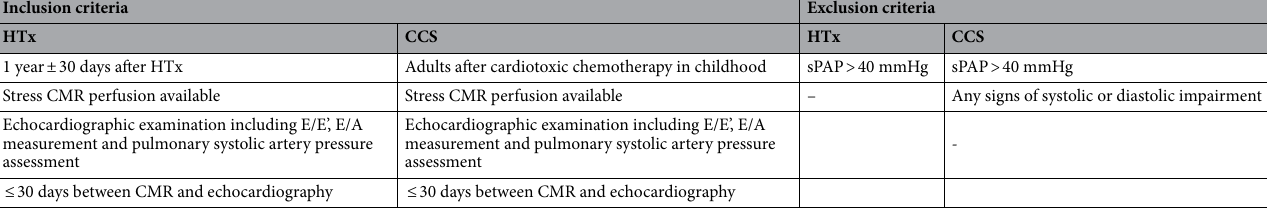
Table 1. Inclusion and exclusion criteria. CMR cardiovascular magnetic resonance, CCS childhood cancer survivors, HTx heart transplant group, sPAP systolic pulmonary artery